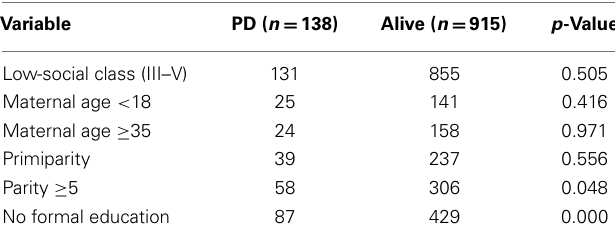
Table 2 | Maternal socio-demographic characteristics association with